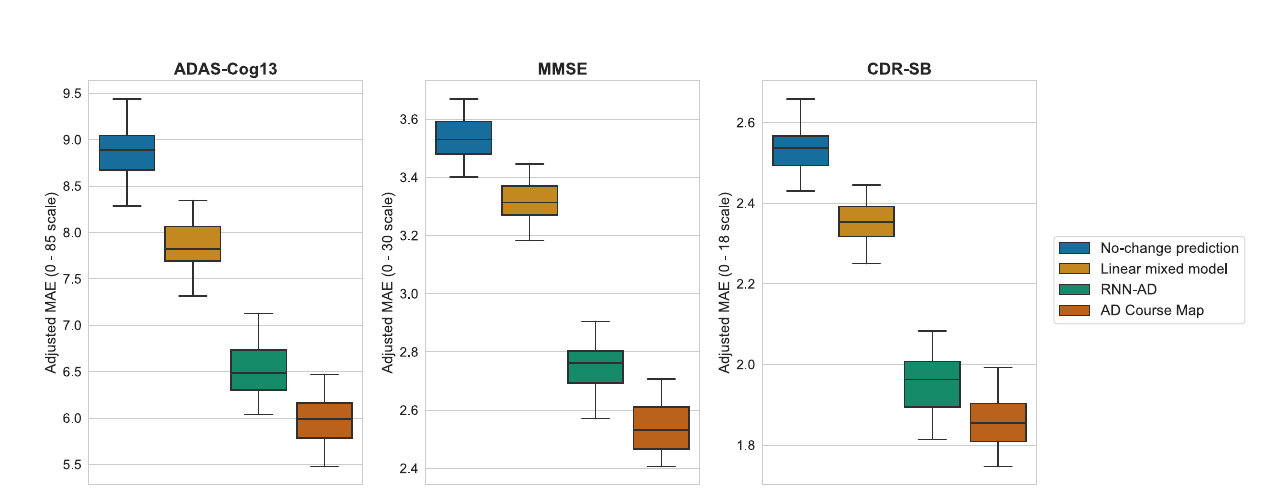
Fig. 2 | AD Course Map forecasts cognitive decline better than alternative methods. The mean absolute error is reported for the reference participant: a 75- year-old AmericanwomanfromADNIwith anaverage levelof education, noAPOE- ε 4 mutation, and a A+T+N+C~ status (i.e., with CDR global of 0.5), for whom we forecast neuropsychological assessments in three years ’ time, based on two past